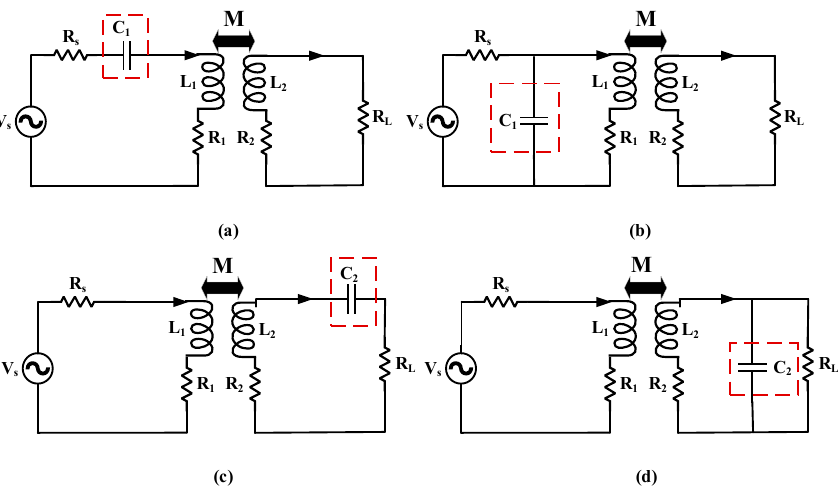
Figure 13. Single-element resonant topologies: ( a ) transmitter series, ( b ) transmitter parallel, ( c ) receiver series, and ( d ) receiver parallel.